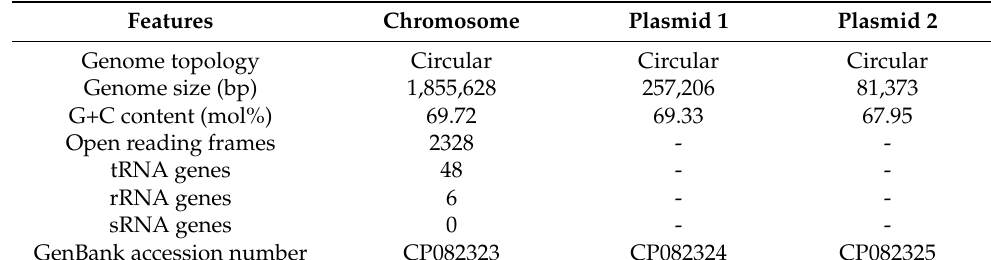
Table 2. Overview of genomic features of T. thermophilus N-1.